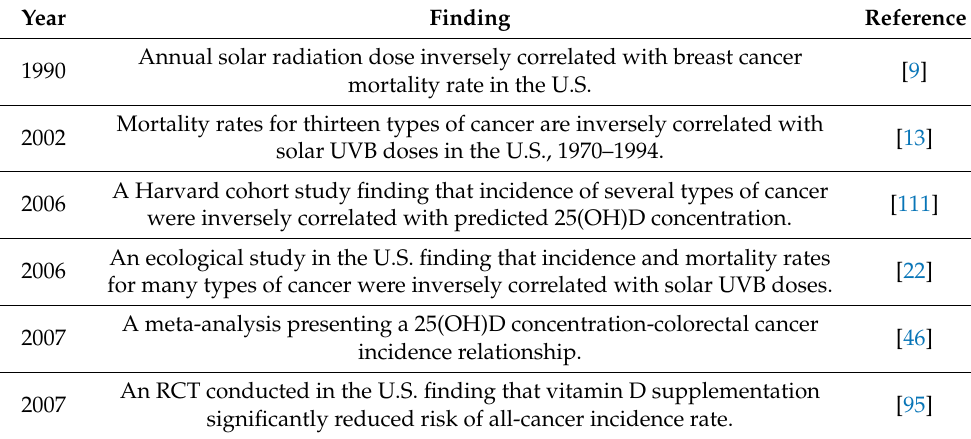
Table 10. Cont. Year Finding Reference Annual solar radiation dose inversely correlated with breast cancer 1990 mortality rate in the U.S. Mortality rates for thirteen types of cancer are inversely correlated with 2002 solar UVB doses in the U.S., 1970–1994. A Harvard cohort study finding that incidence of several types of cancer 2006 were inversely correlated with predicted 25(OH)D concentration. An ecological study in the U.S. finding that incidence and mortality rates 2006 for many types of cancer were inversely correlated with solar UVB doses. A meta-analysis presenting a 25(OH)D concentration-colorectal cancer 2007 incidence relationship. An RCT conducted in the U.S. finding that vitamin D supplementation 2007 significantly reduced risk of all-cancer incidence